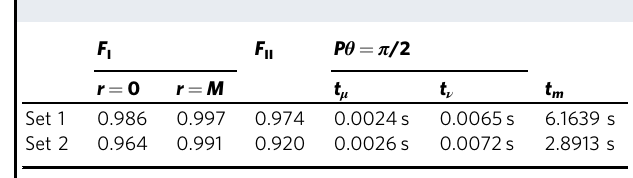
Table 1 Fidelities for Protocols I and II.